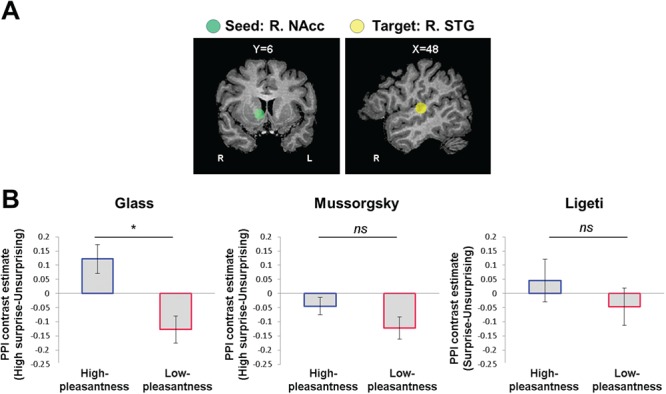
Surprise-related NAcc–STG functional connectivity varies as function of music-induced pleasantness. (A) The NAcc (L) and STG (R) ROIs used for a PPI analysis comparing the surprise-related functional connectivity between the high- and low-pleasantness groups. (B) Surprise-related connectivity is represented per group and musical piece (Glass, L; Mussorgsky, center; Ligeti, R) as the difference between PPI parameter estimates (beta) of surprising relative to US conditions. High- and low-pleasantness groups are marked by blue and red contours, respectively. The asterisk above the graph bars indicates the significance of group comparisons: *P < 0.005; qFDR < 0.05. Error bars represent 1 SEM.